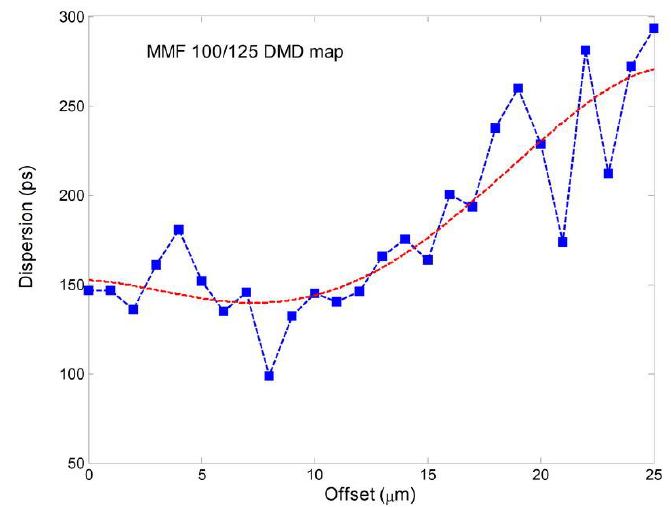
Figure 15. Results of dispersion evaluation.